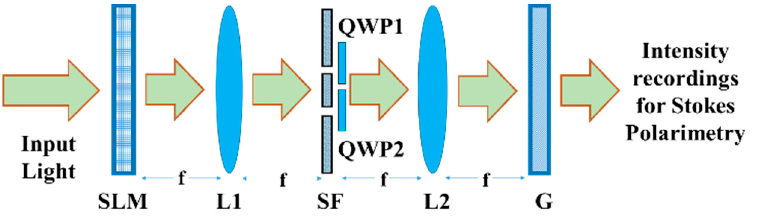
Figure 3 . Schematic diagram for information encoding into SVP beam L: lens, f: focal length, G: grating.